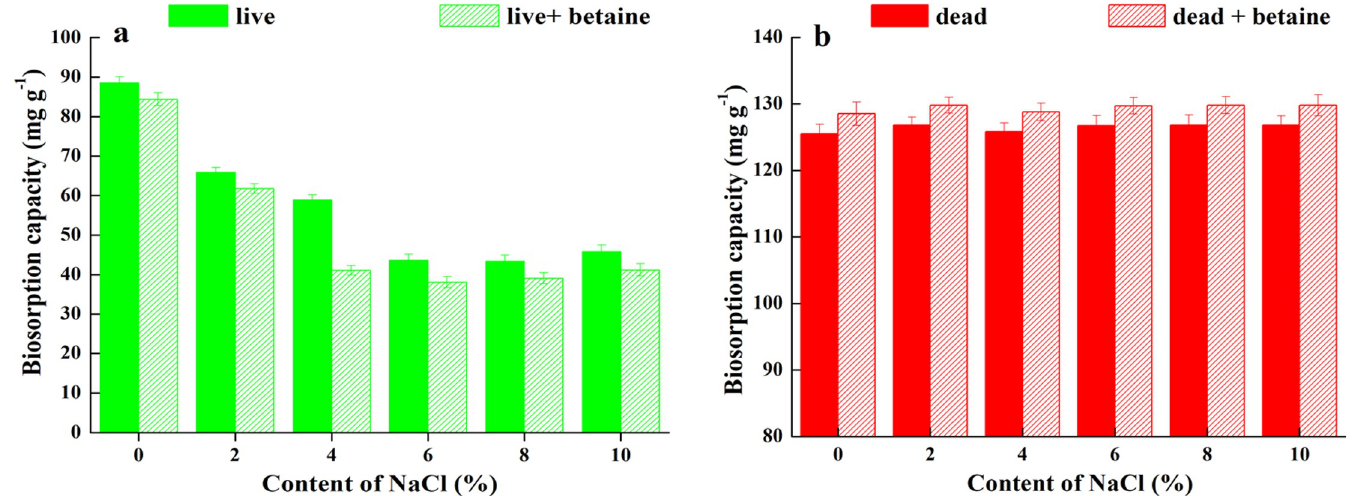
Fig 4. Biosorption capacity of Pb 2+ by adding 150 mg L -1 betaine on solution of live(a) and dead(b) biosorbents over NaCl ranging from 0–10%.